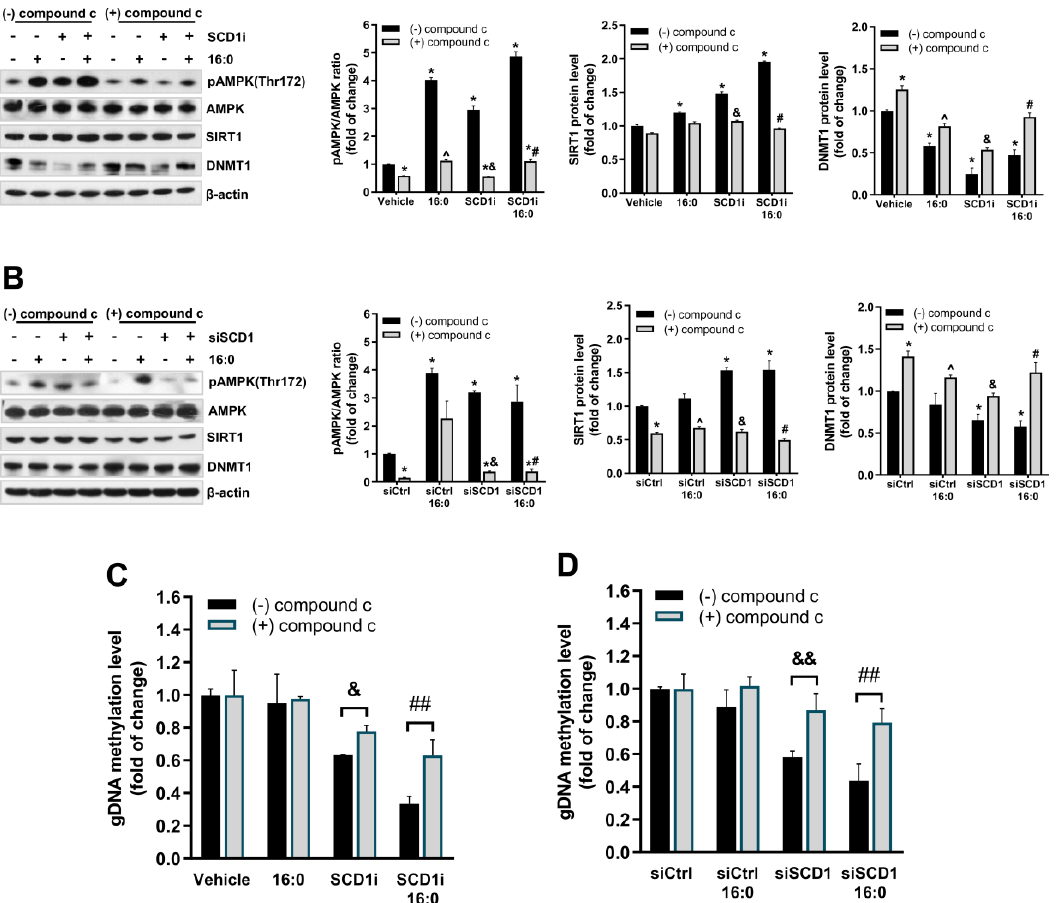
Figure 6. Inhibition of AMPK in SCD1-deficient INS-1E cells increases DNMT1 protein levels and prevents gDNA hypomethylation under conditions of SCD1 deficiency. ( A , B ) DNMT1 levels in INS-1E cells that were co-treated with the SCD1 inhibitor A939572 (SCD1i) ( A ), siSCD1 ( B ), palmitic acid (16:0), and 10 µM compound c to block AMPK. The levels of AMPK phosphorylation at Thr172 (pAMPK Thr172) and SIRT1 and DNMT1 protein content were measured by Western blot. ( C , D ) Effect of AMPK inhibition by compound c on gDNA methylation levels in INS-1E cells with the inhibition of SCD1 activity ( C ) and SCD1 gene silencing (siSCD1) ( D ). * p < 0.05, vs. Vehicle/siCtrl; ^ p < 0.05, vs. 16:0/16:0+siCtrl, & p < 0.05, && p < 0.005, vs. siSCD1/SCD1i; # p < 0.05 , ## p < 0.005, vs. SCD1i/siSCD1+16:0. The data are expressed as the mean ± SD of three independent experiments. AMPK: adenosine monophosphate-activated protein kinase; SIRT1: NAD-dependent deacetylase sirtuin-1.